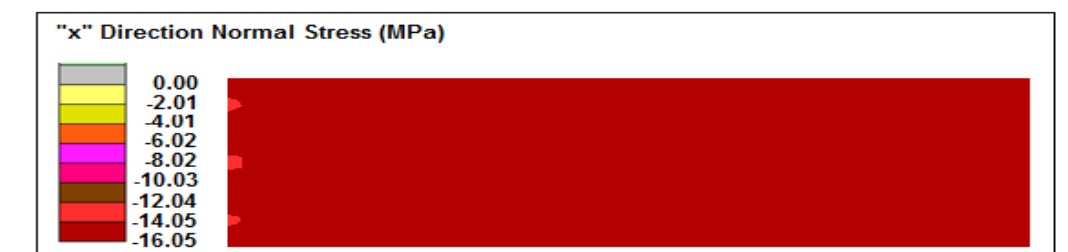
Figure 7. Field of normal stresses at the instant of loading – Case